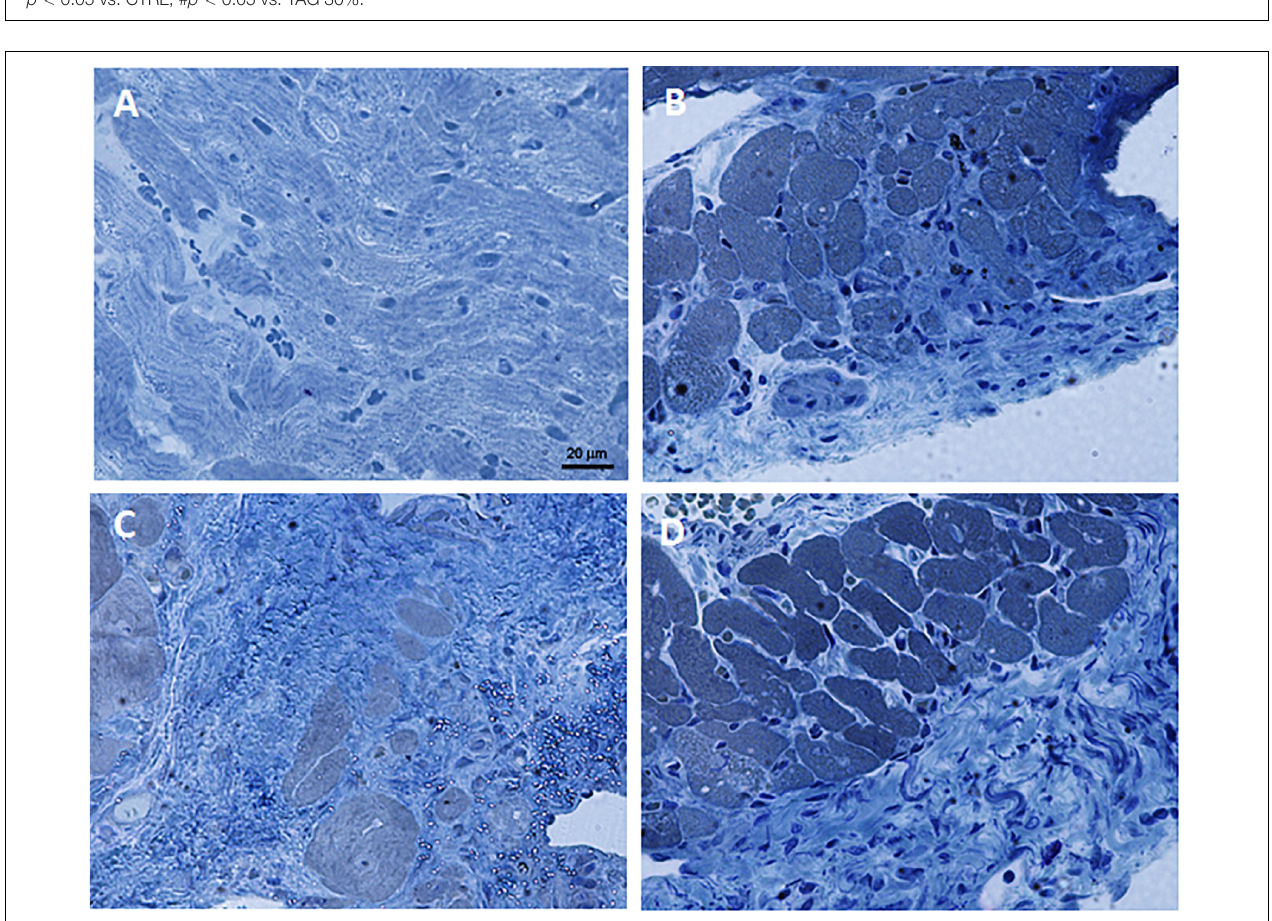
FIGURE 4 | Representative images of AZAN-stained histological sections of heart tissue samples. (A) Naïve. (B) Ischemia/reperfusion CTRL group. (C) Ischemia/reperfusion FRU 30% group. (D) Ischemia/reperfusion TAG 30% group. 40 ×